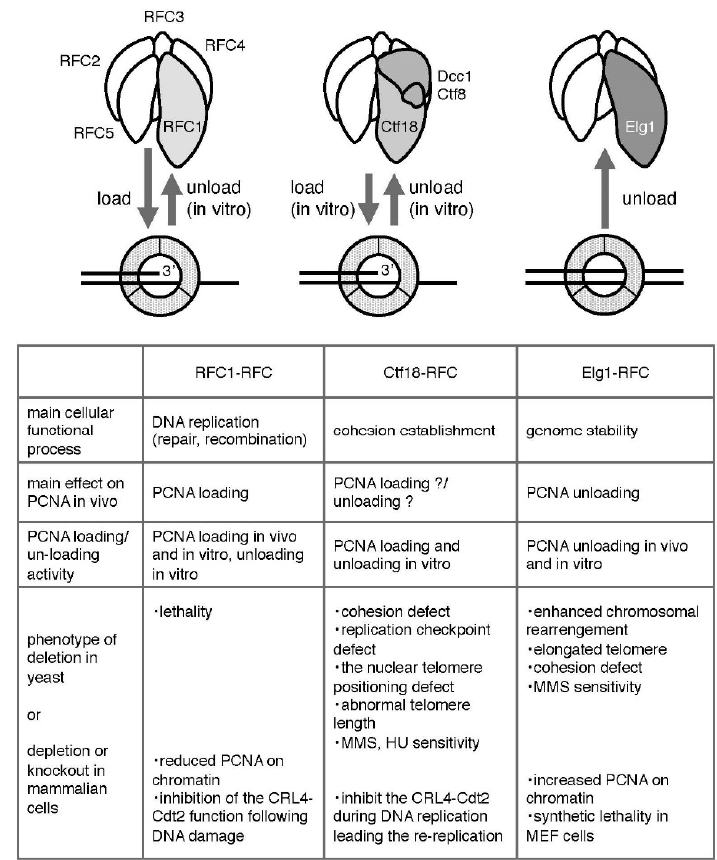
Figure 1. Summary of the functions of the three RFC complexes transacting on PCNA [17]. See text for details. The “?” marks in the table mean that the main effect of Ctf18-RFC (loading and unloading) on PCNA in vivo is not well understood.